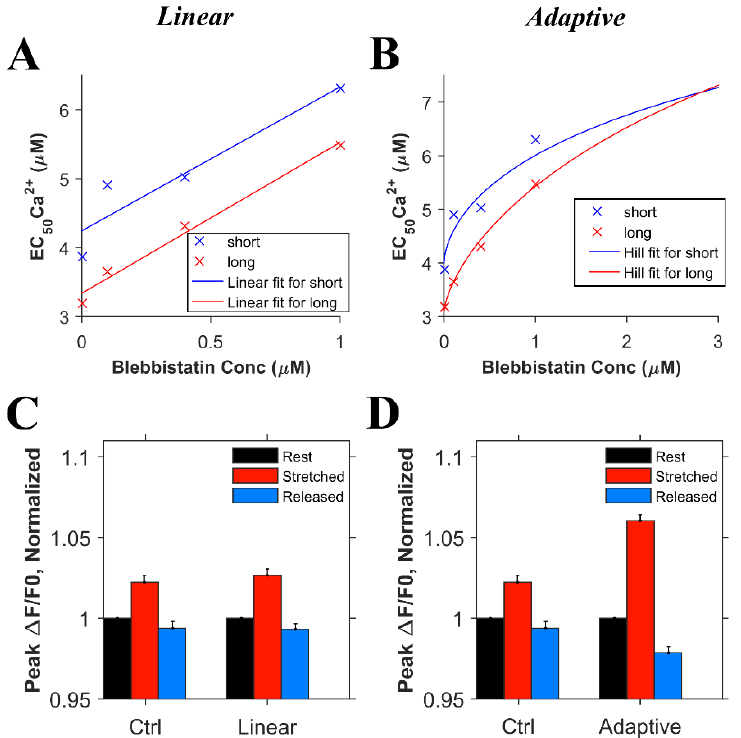
Figure 4 . The effects of blebbistatin on the Ca 2+ binding affinity of troponin. A . A linear fit suggests that the length-dependent difference in binding affinity remains relatively constant as a ~20% decrease in EC50. The × symbols represent the experimental data from Farman et al. [18] and the lines the fit. Blue denotes short sarcomere lengths, while red denotes long sarcomere lengths (mean squared error = 0.085) B . An adaptive fit using the Hill equations show that the length-dependent difference in the binding affinity decreases and eventually disappears with increasing blebbistatin concentration (mean squared error = 0.062). C . Simulation results (n = 20 simulations) for the comparison between control and adaptive cases. D . Simulation results (n = 20 simulations) control and adaptive cases.